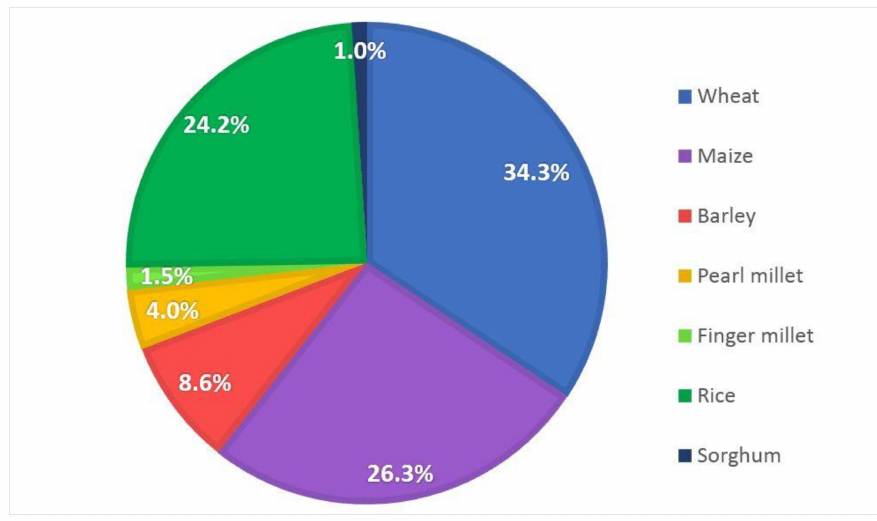
Figure 1. Share of each cereal in original scientific papers on the use of